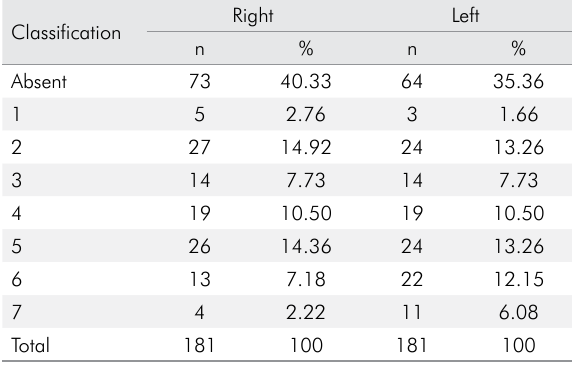
Table 5. Absolute and relative numbers of location classification in accordance with Oliveira-Santos et al.11 for the gathered